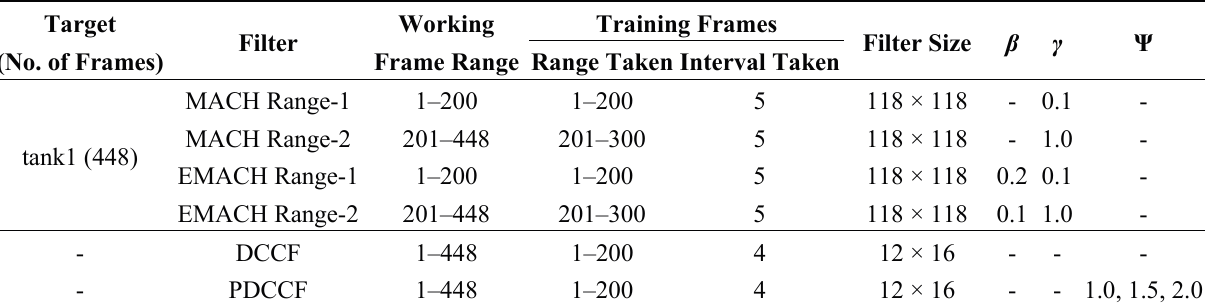
Table 1. Training data for Sequence L2018.